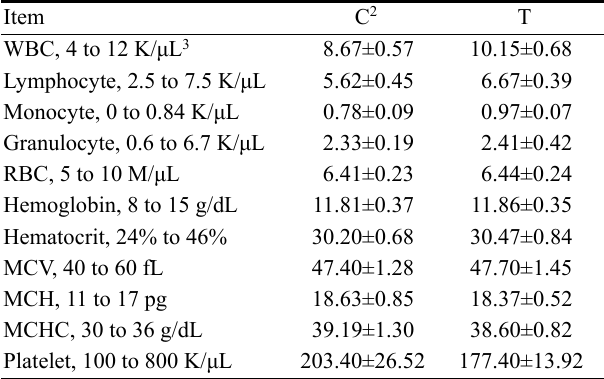
WBC, white blood cell; RBC, red blood cell; MCV, mean corpuscular volume; MCH, mean corpuscular hemoglobin; MCHC, mean corpuscular hemoglobin concentration. 1 Values are expressed as mean±standard error of the mean (n = 10). 2 C, control; T, phytoncide (0.016%/feed). 3 Normal